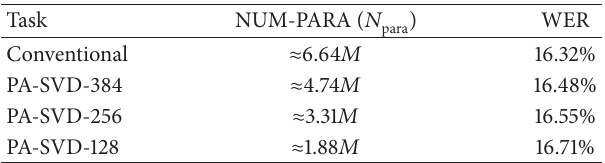
Table 1: WERs and model